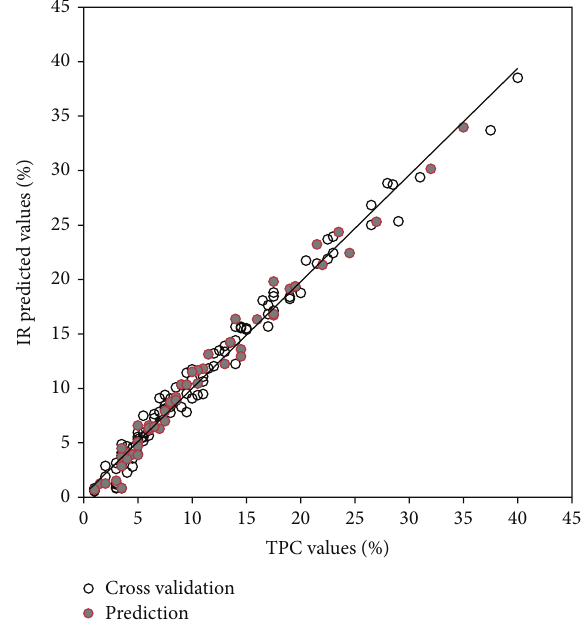
Figure4:RelationshipbetweenactualandIR-predictedTPCvalues.